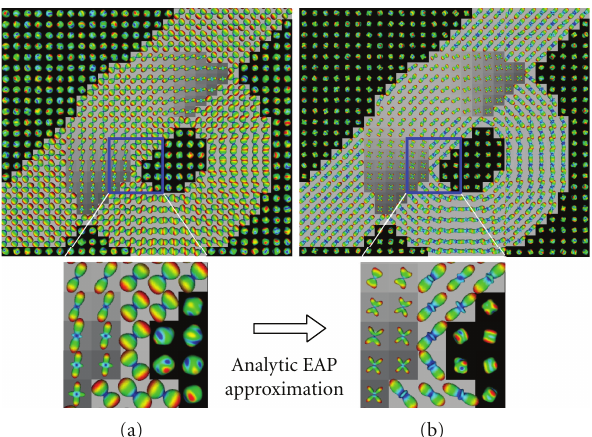
Figure 2: Synthetic dataset experiment. Two fiber bundles intersecting with the DWI signal corrupted by a Rician noise of SNR = 30. (a) (cid:2) ADC from 4th-order tensors. (b) Analytically approximated EAP, Pr (7) 4,4 .